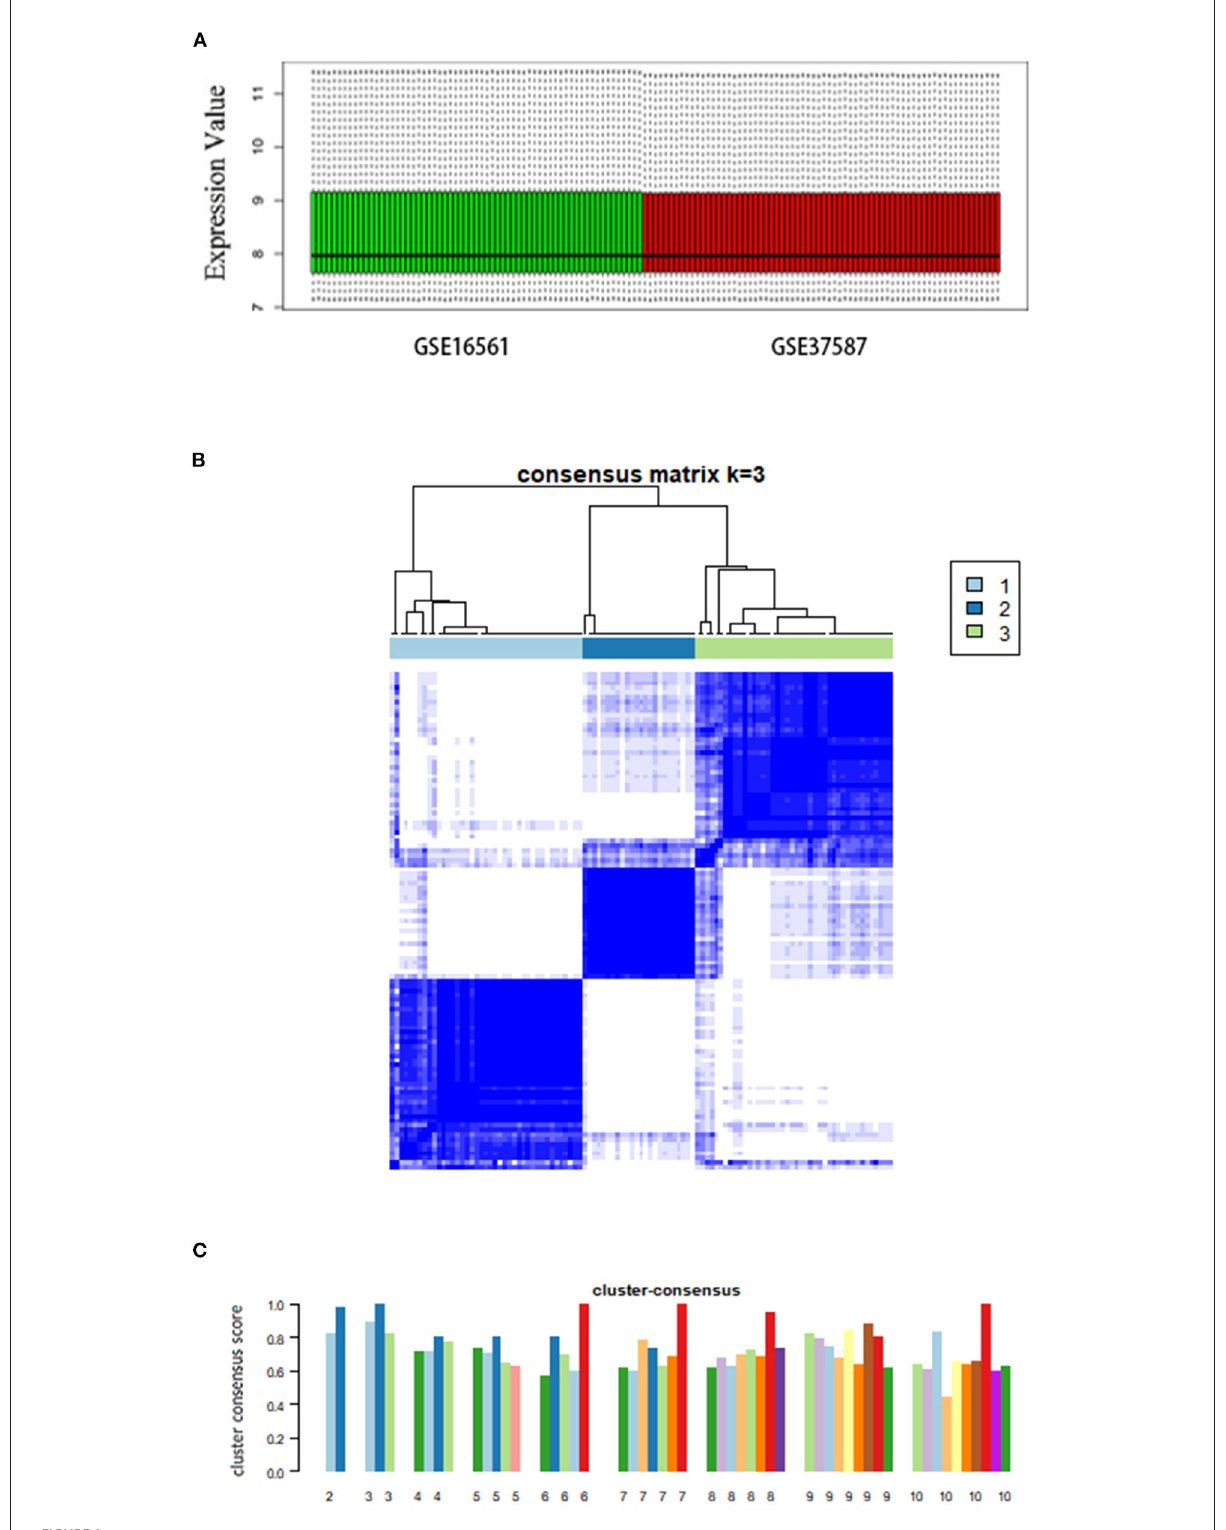
FIGURE1 Consensus clustering analysis of gene expression profiles of peripheral blood samples in patients with AIS. (A) Box plots showing the normalized relative expression (y-axis) of data from genesets GSE16561 and GSE37587. (B) The heatmap representing the consensus matrix with a cluster count of 3, which was determined by the minimal consensus scores of > 0.8. (C) Bar-plots showing the consensus scores (y-axis) and the corresponding numbers of the subgroup. The maximum number of subgroups was set to